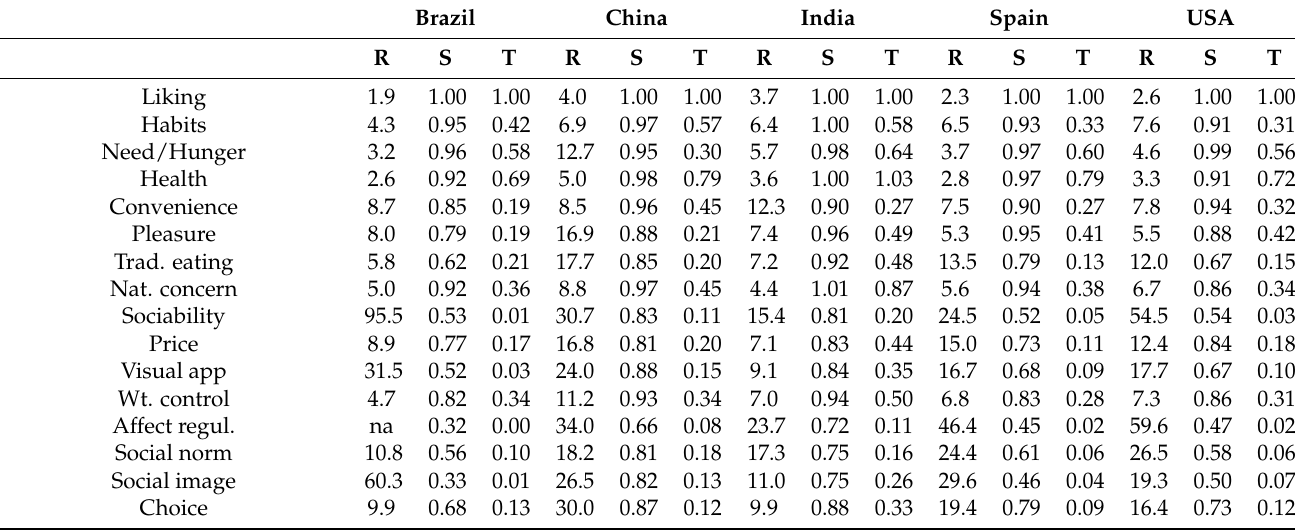
Table A5. Ratios of RATING “apply” responses to RATA “apply” responses (R) and standard indices of importance for RATING (S) and RATA (T) “apply” responses for each motivation construct to the liking motivation construct for fruits and vegetables in all five countries.